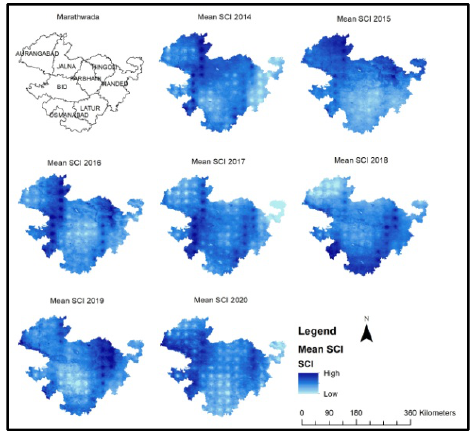
Figure 4: Annual mean SCI over Marathwada for 2014-2020